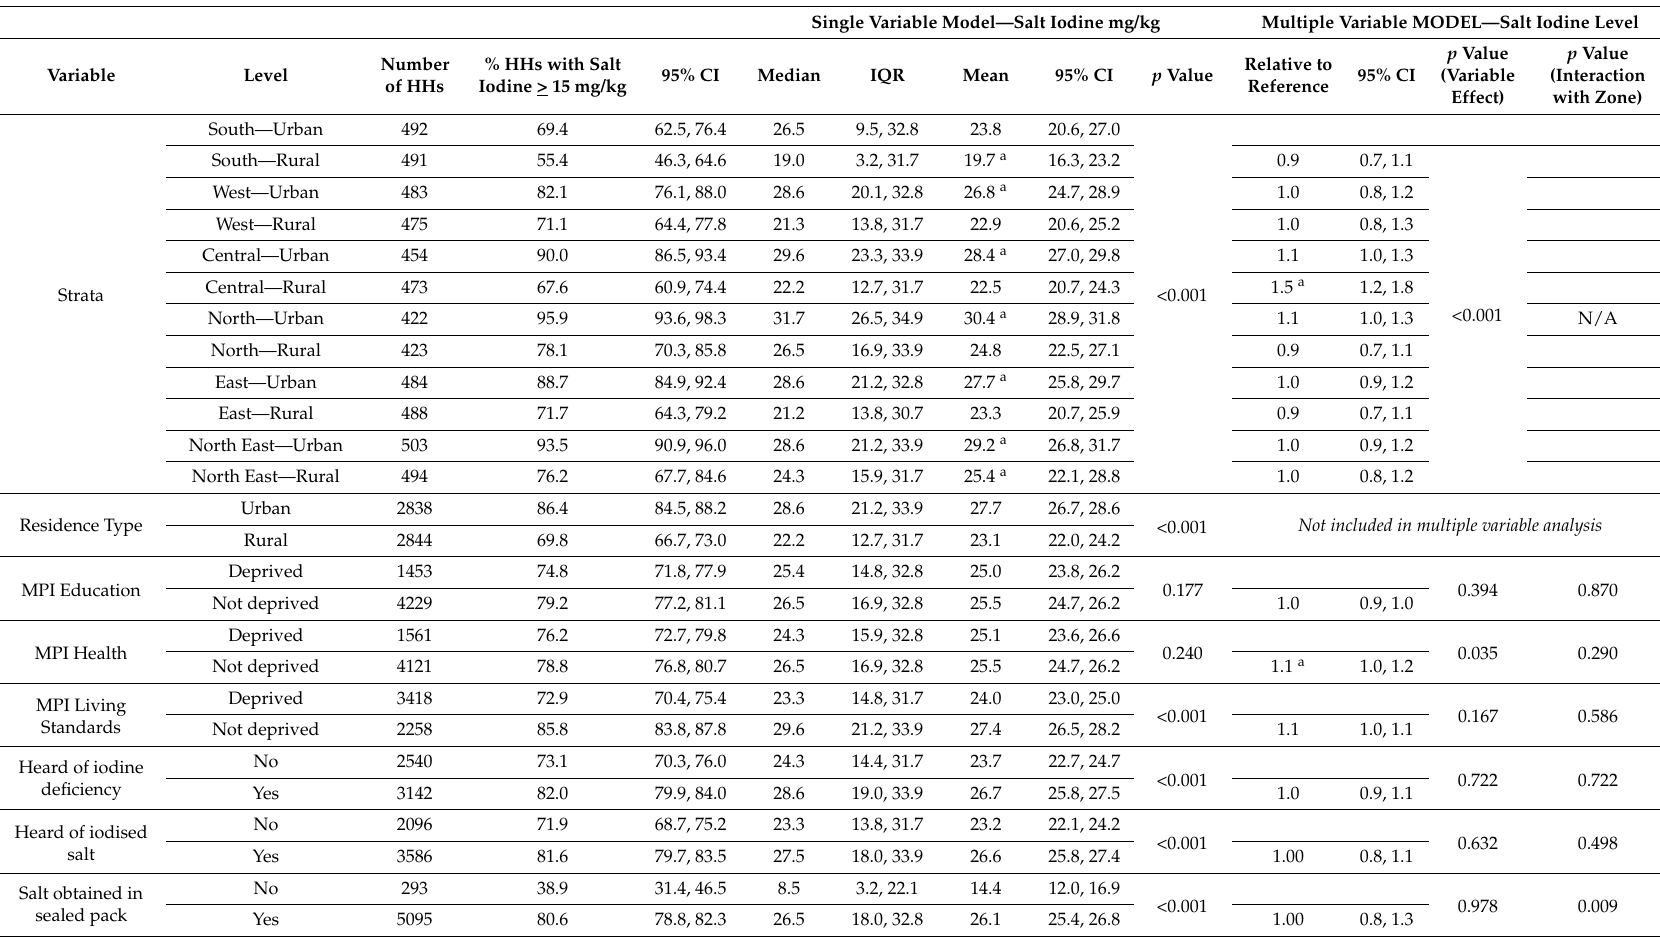
Table 3. Regression analyses of factors associated with household salt iodine